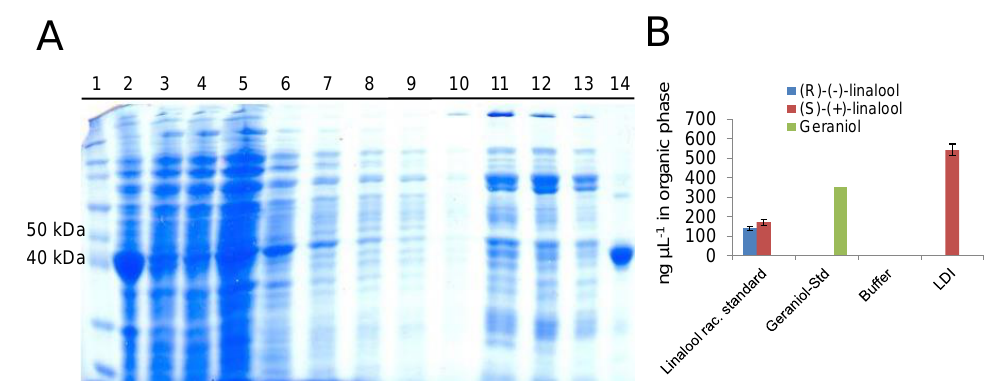
Figure 3. Purified Ldi catalyzes the enantioselective formation of ( S )-(+)- linalool from β -myrcene. ( A ) Purification of Ldi from E. coli lysate via Ni-NTA affinity chromatography. Four µL of TCL and CFE (lanes 2 and 3), 10 µ L of flow through (lane 4), washing fractions with 10 mM imidazole (lanes 5 to 10) and washing fractions with 50 mM imidazole (lanes 11 to 13), as well as 1 µ L of purified and concentrated Ldi were loaded onto the gel. Novex TM Sharp Prestained Protein Standard was used as the molecular weight marker (lane 1). ( B ) In vitro conversions of β -myrcene with 1 mg mL − 1 of purified Ldi.